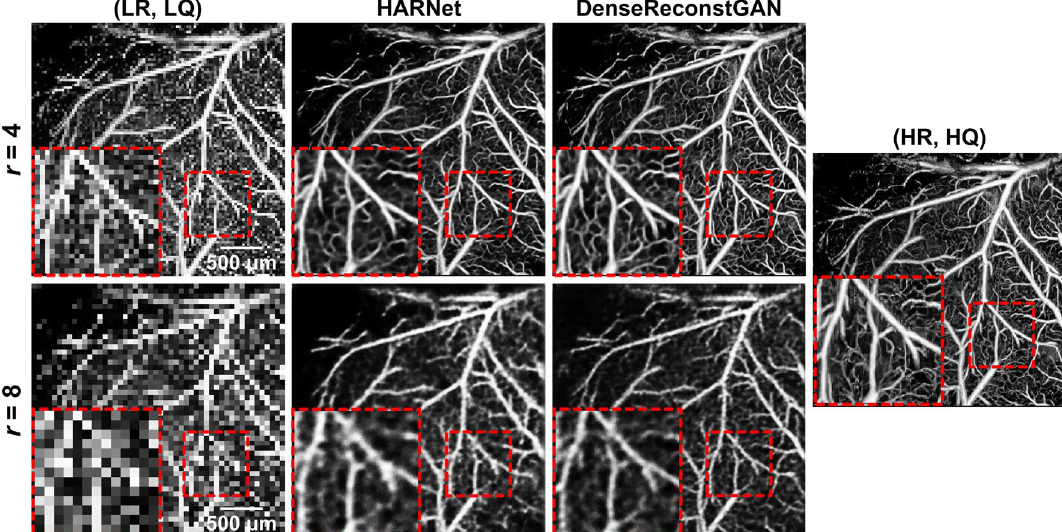
Figure 6. Qualitative performance of our DenseReconstGAN and HARNet for reconstructing at downsampling ratios (denoted as r ) of four and eight. (LR, LQ) low-resolution and low-quality, (HR, HQ) high-resolution and high